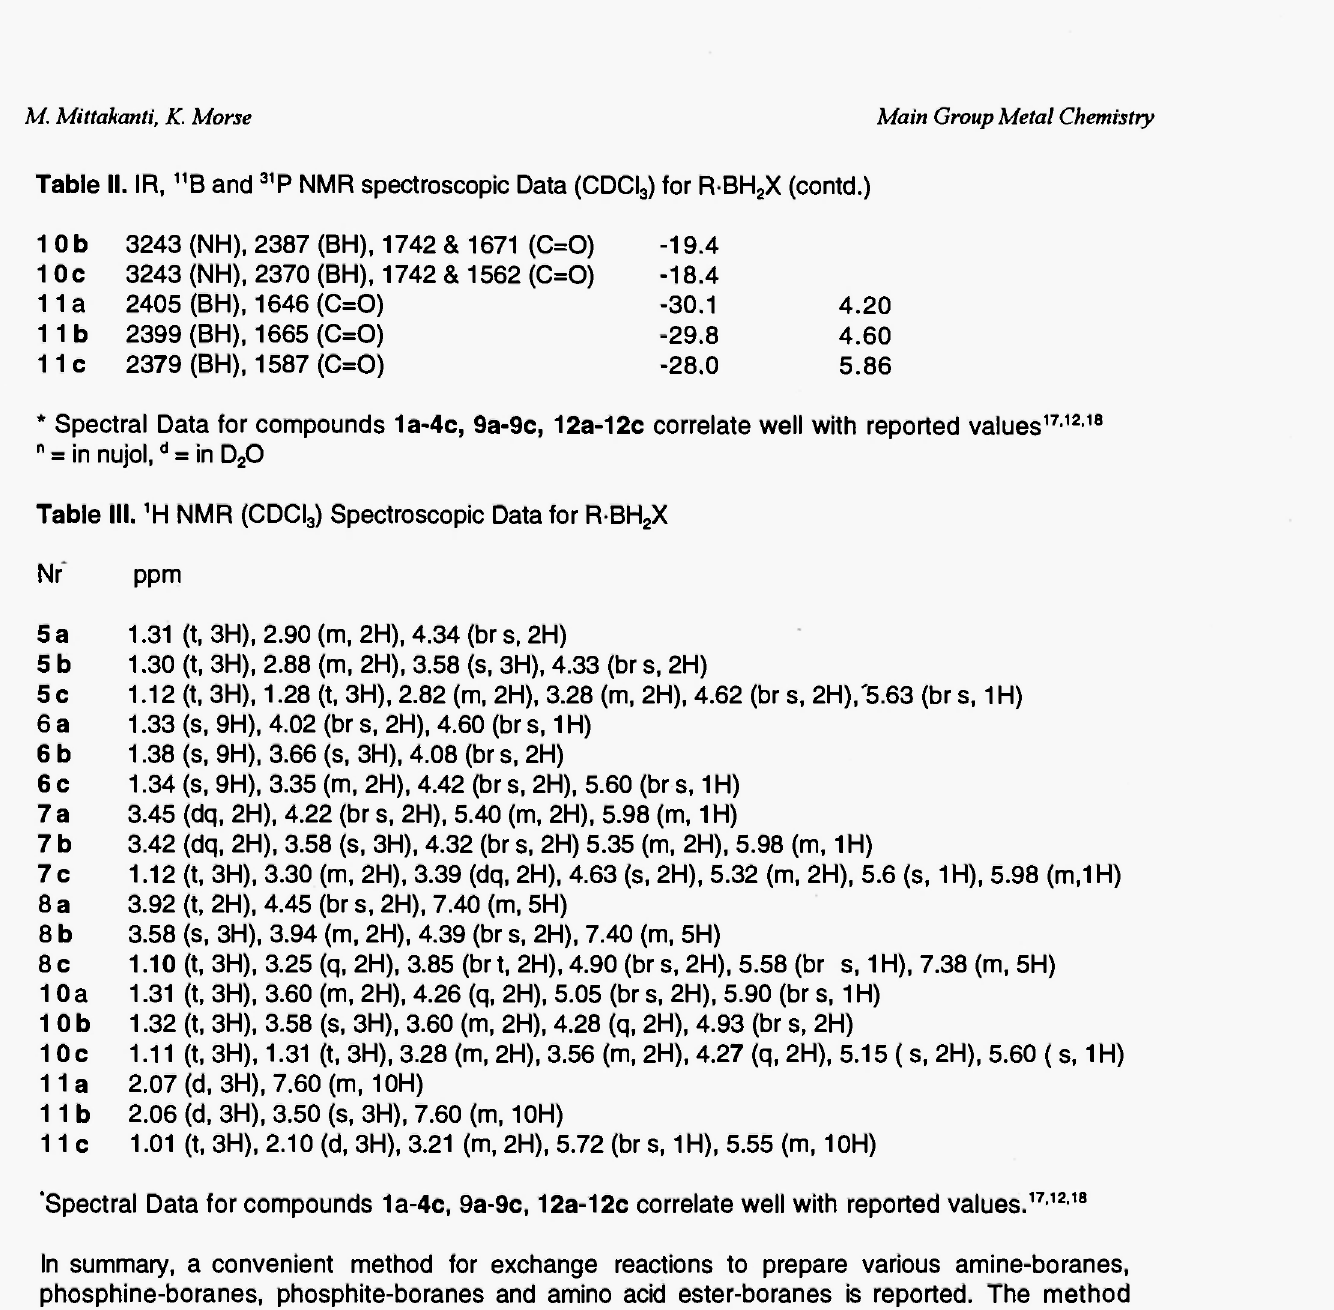
) for R BH X (contd.) 3 Z